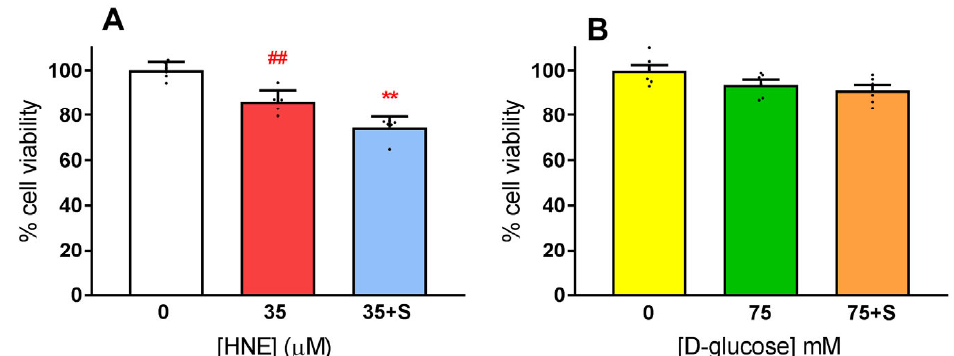
Figure 10. Effect of AKR1B1 inhibition on cell viability of HLE cells undergoing different stress. HLE cells were grown as described in Section 2.2; cell viability was evaluated as described in Section 2.3, and expressed as % with respect to the value measured for untreated cells. ( A ) HLE cells were maintained for 6 h in MEM containing 0.05% DMSO, in the presence of the indicated HNE concentration. S refers to the addition of 10 µ M sorbinil. Values are the mean ± SEM of six independent measurements. Statistical analysis was performed using one-way ANOVA with Tukey post hoc test. Significance was evaluated with respect to untreated cells ( ## : p < 0.01), or with respect to cells incubated with 35 µ M HNE (**: p < 0.01). ( B ) HLE cells were maintained for 24 h in MEM containing 0.05% DMSO, in the presence of the indicated D-glucose concentration. S refers to the addition of 10 µ M sorbinil. Values are the mean ± SEM of six independent measurements. Statistical analysis was per ‐ formed using one ‐ way ANOVA with Tukey post hoc test. Significance was evaluated with respect to untreated cells.